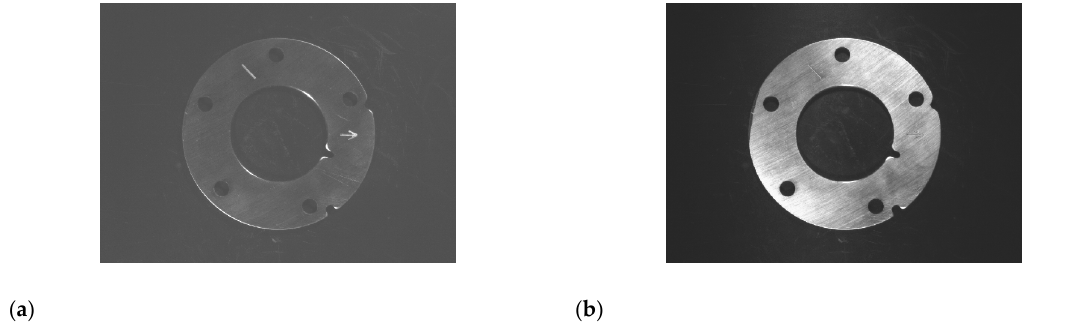
Figure 7. The image of di ff erent grinding marks angle: ( a ) the grinding marks angle closes to 90 degree; ( b ) the grinding marks angle closes to 0 degree.